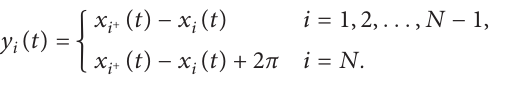
Figure 1. In a fixed coordinate system, the state of the an- gular position of the agent i at time t is denoted by x i ( t ) .